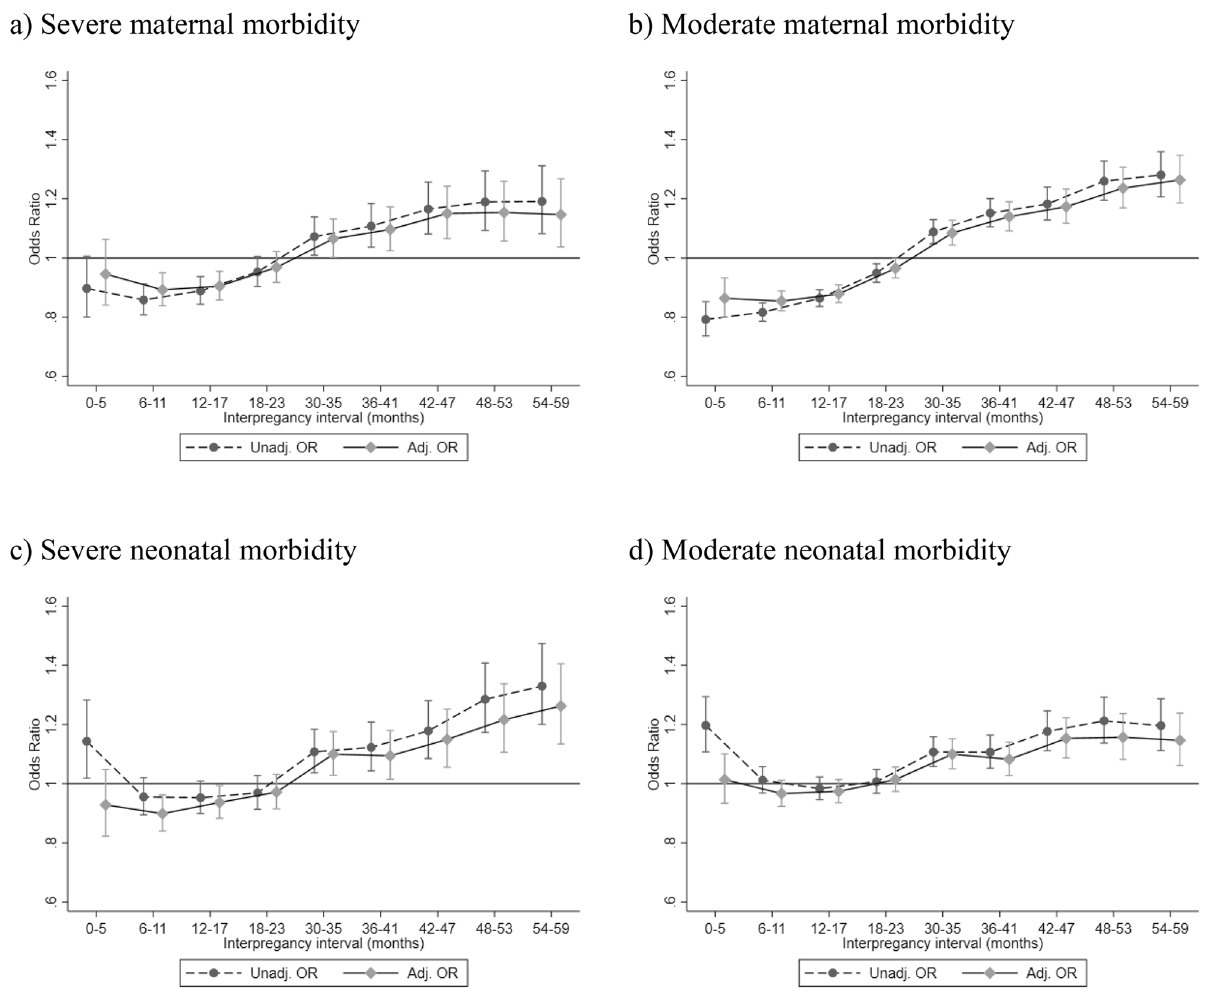
Figure 1. Association between interpregnancy interval and maternal and neonatal morbidity. Unadj: unadjusted, Adj: adjusted, OR: odds ratio. The odds ratios are presented with 95% confidence intervals